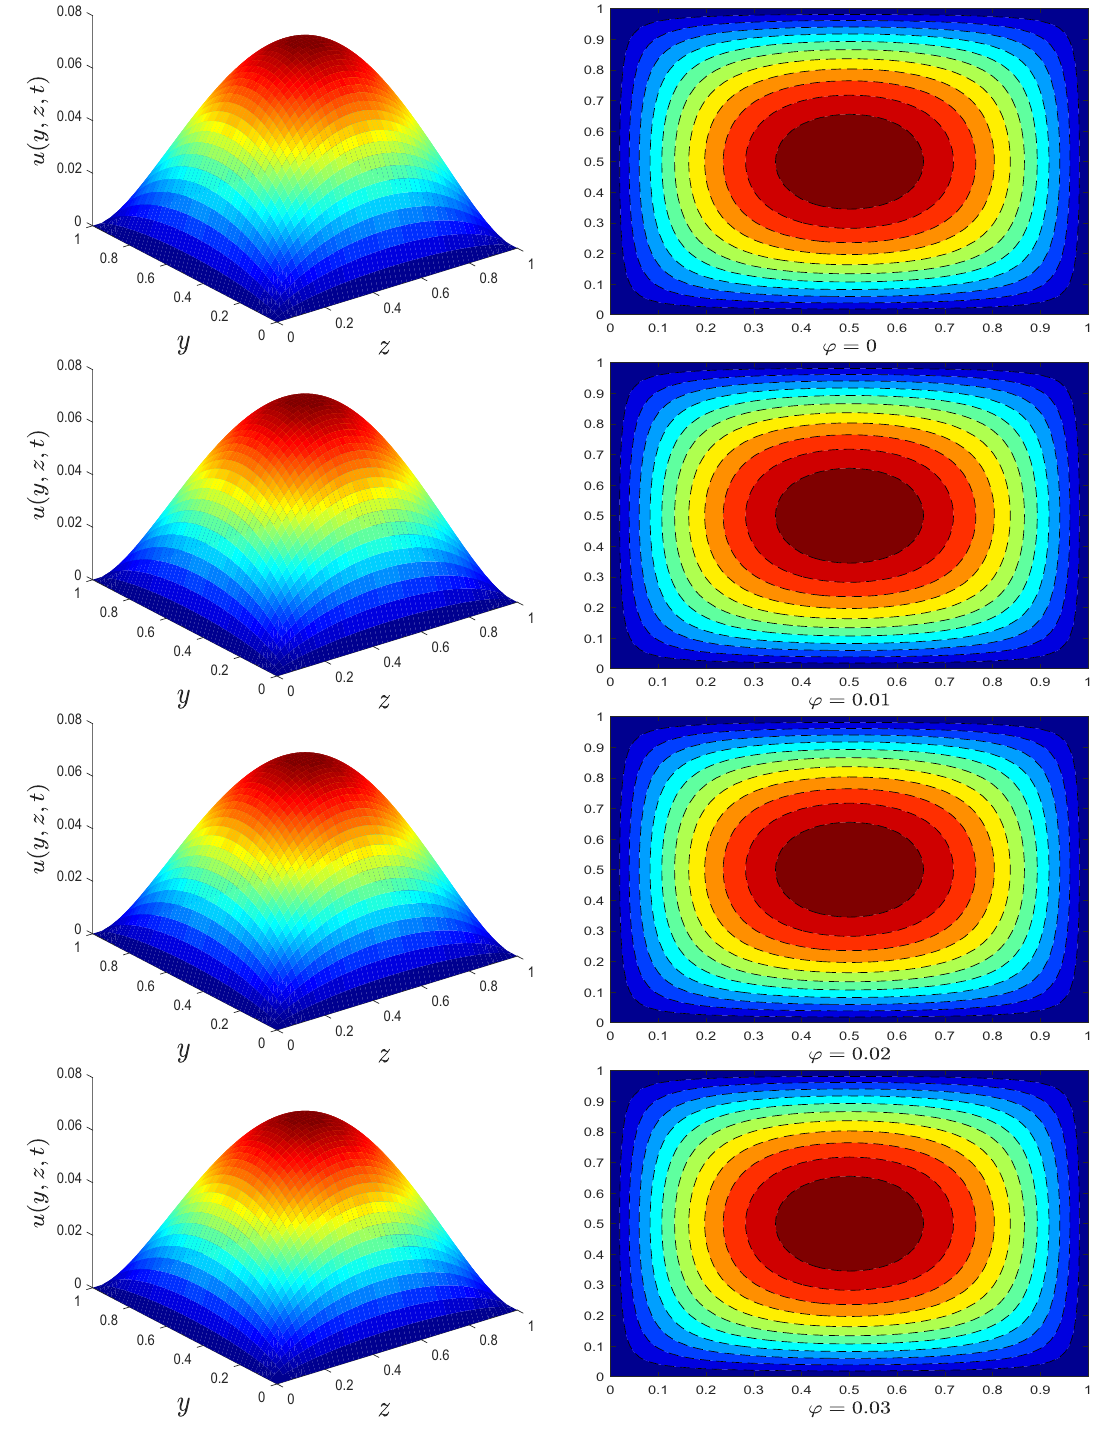
Figure 3. Velocity profile for different values of nanotube volume fraction ϕ